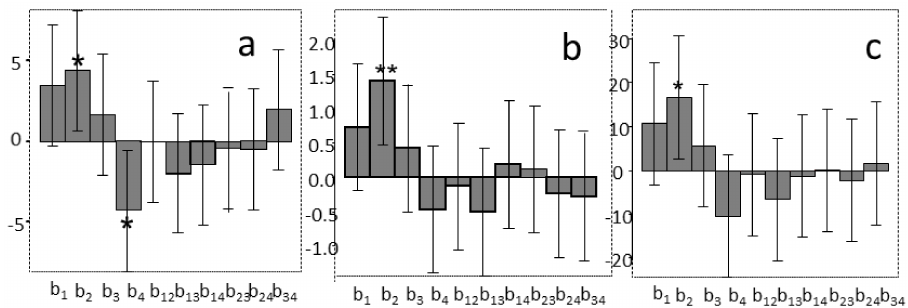
Figure 5. The coefficients of the models of ( a ) Y 1 ( µ mol TEAC/g sample), ( b ) Y 2 (mg GAE/g sample), and ( c ) Y 3 (medium value of the corresponding scaled Y 1 and Y 2 ) obtained by the Full Factorial Design (X 1 , amplitude; X 2 , pulse; X 3 , time; X 4 , sample/solvent ratio).* = p < 0.05, ** = p <